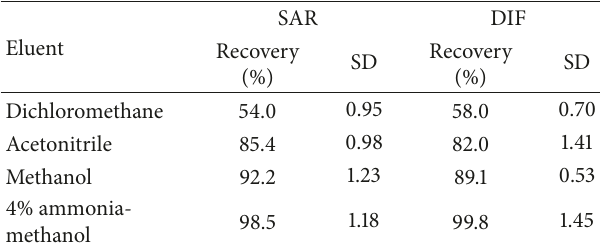
Table 2: Recoveries of fluoroquinolone extracted with different solvent